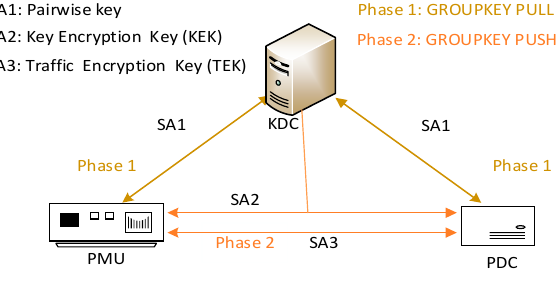
Figure 5. GDOI key distribution model.